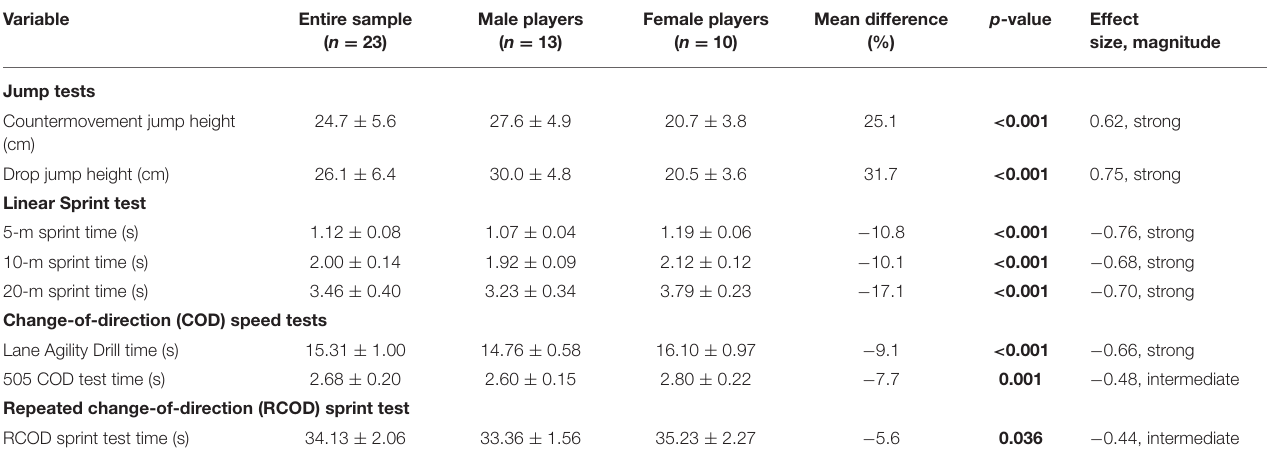
TABLE 1 | Comparisons in physical fitness attributes between elite, male and female under 14 basketball players.